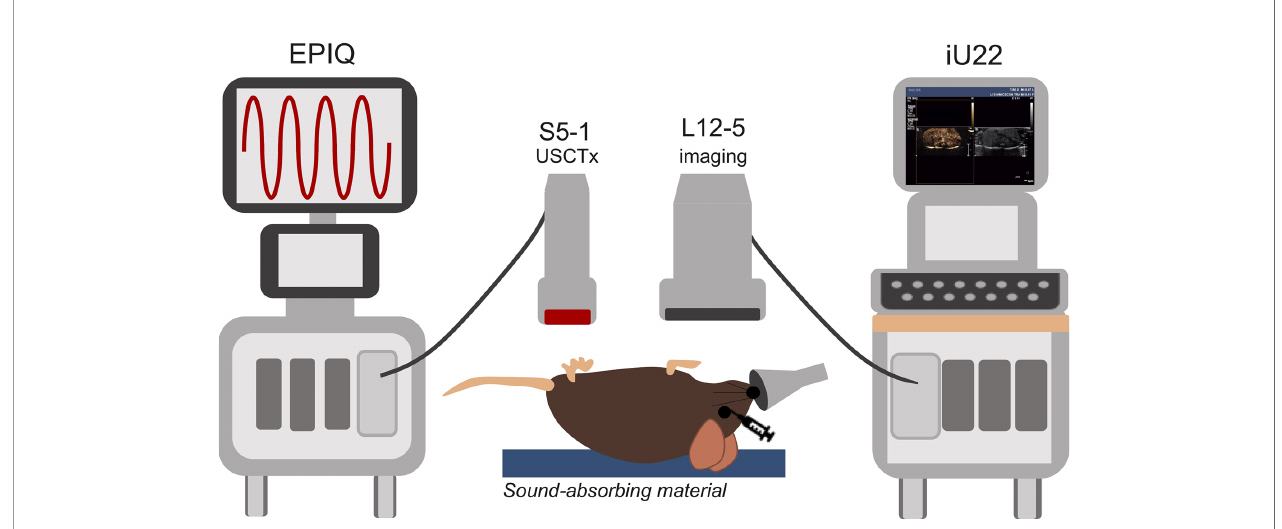
FIGURE 1 | Overview of experimental setup. The EPIQ and S5-1 probe were programmed to produce ultrasound conditions for cavitation treatments. The iU22 with the L12-5 probe were used for contrast enhanced ultrasound (CEUS) imaging before and after cavitation treatments as well as routine monitoring of tumor growth. Mice were placed on a sound-absorbing material to minimize sound reverberations.